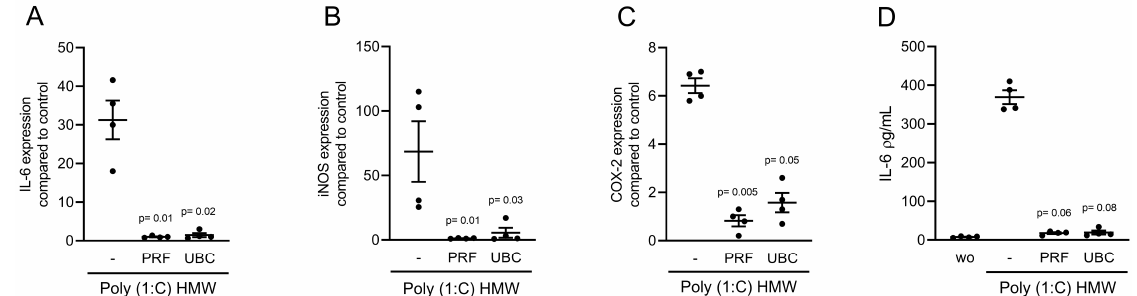
Figure 6. Lysates extracted from PRF or UBC can reduce TLR3 agonist-induced inflammation in RAW264.7 cells. RAW264.7 cells were exposed to 30% lysates extracted from PRF and UBC membranes in the presence of 10 µ g/mL poly (1:C) HMW. ( A – C ) The data show the x-fold changes in IL-6, COX-2, and iNOS gene expression ( D ) and IL-6 levels in the cell supernatant, n = 4. Statistical analysis was based on uncorrected Dunn’s tests, and p values are indicated compared to the poly (1:C) HMW group. Significance was set at p <